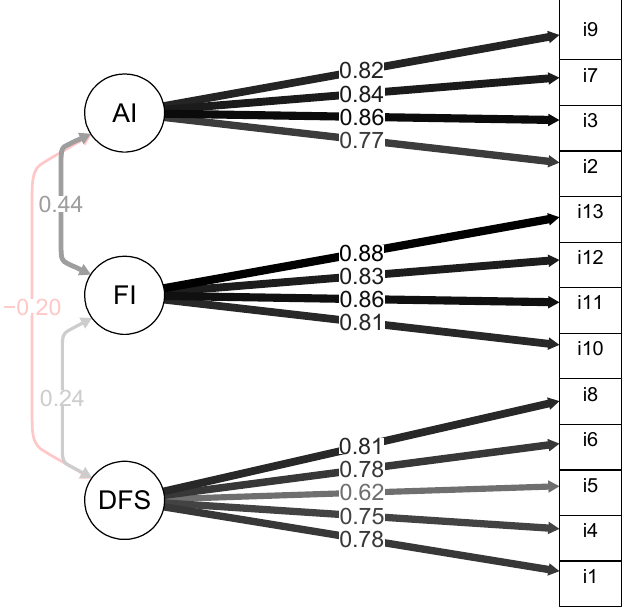
Figure 1. Path diagram for the three-dimensional model of the muscle dysmorphic disorder inventory (MDDI) in physically active Italian women.